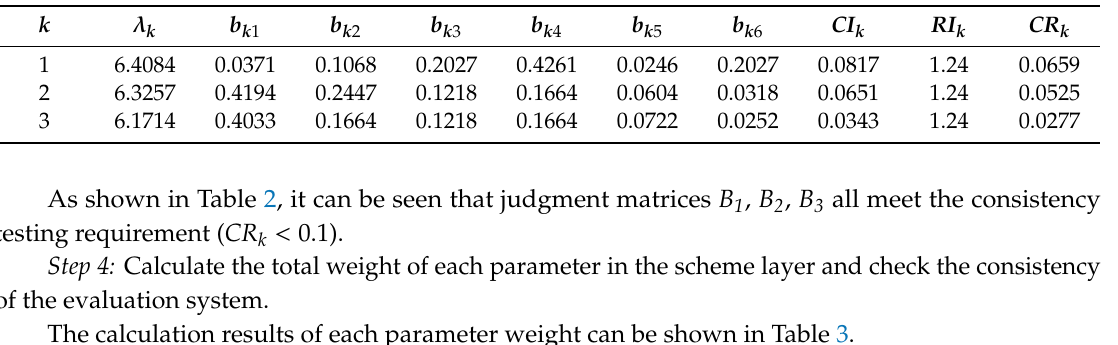
Table 2. Results of consistency testing of matrices B 1 , B 2 , B 3 .